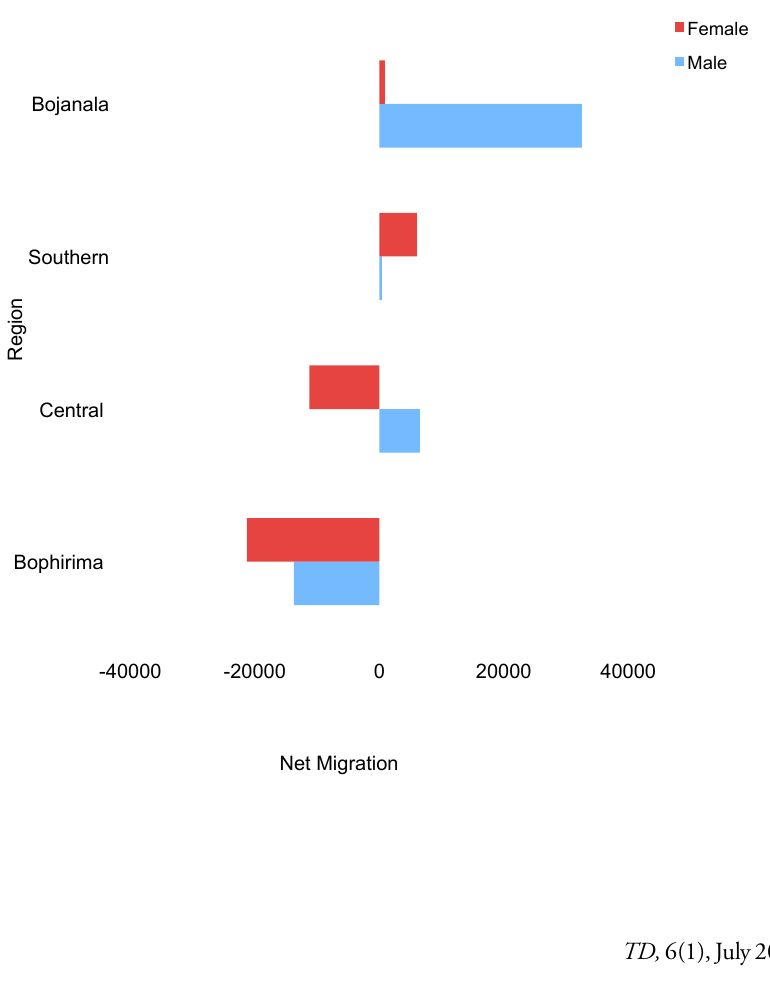
Figure 1 Net Migration by regions, North West,